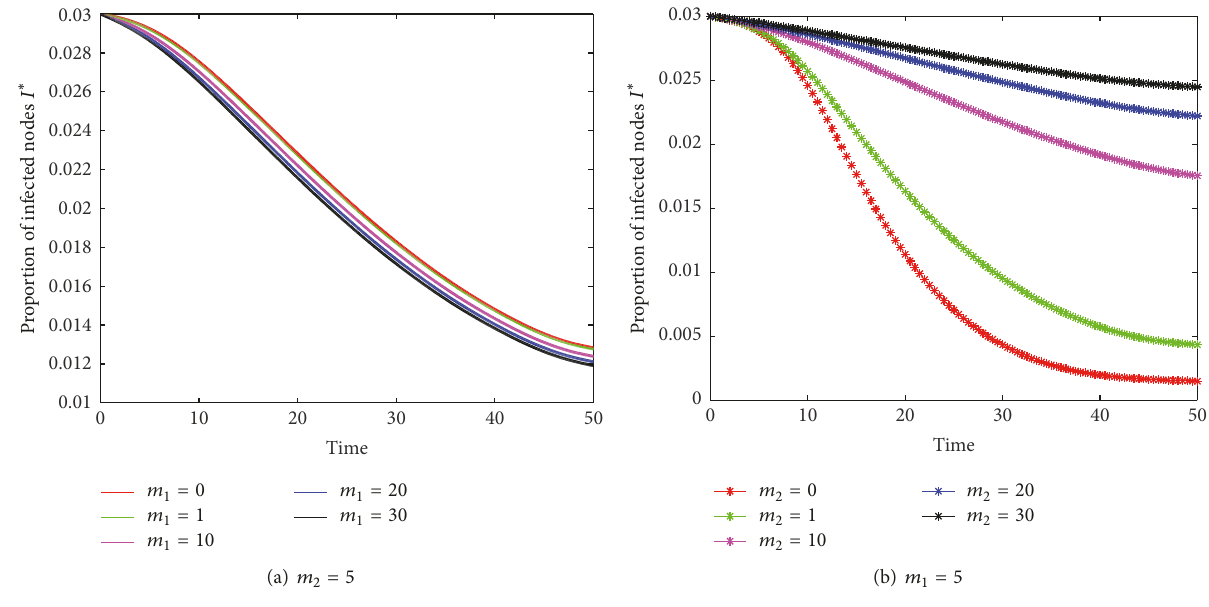
Figure 9: 𝐼 ∗ (𝑡) for different 𝑚 1 and 𝑚 2 for Example 2.